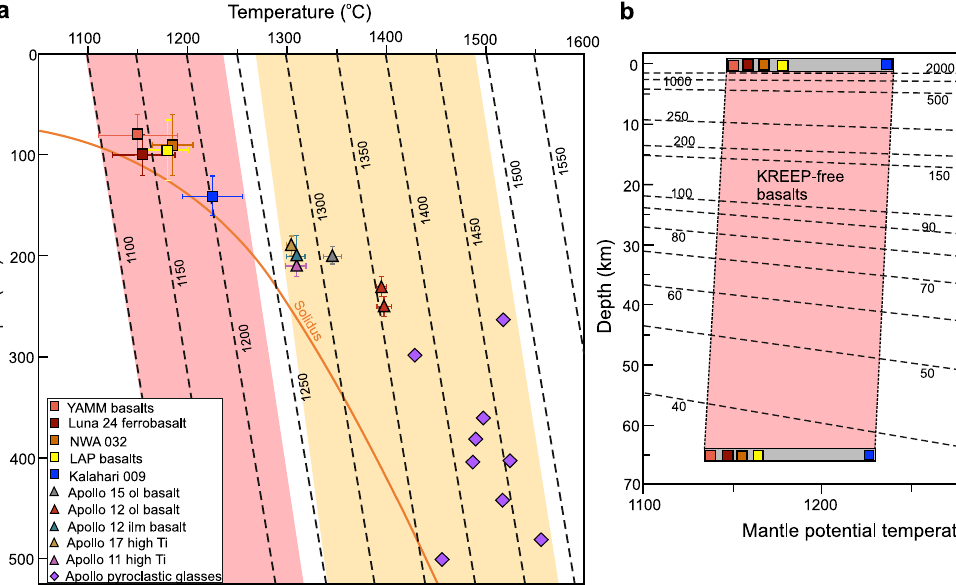
Fig.4|Formationtemperature( T ),pressure( P )andsurfaceheat fl owofKREEP- free basalts compared to other lunar lithologies. a The KREEP-free basalts (red fi eld) show lower formation P - T (see Methods and Supplementary Data 4) than Apollo mare basalts and pyroclastic glasses (orange fi eld). Mantle potential tem- peratures( T p )in °C, areshownasdashed lines.The estimates of P - T forpyroclastic glasses are multiple saturation point data and are adopted from refs. 31, 36 and referencestherein.The P-T